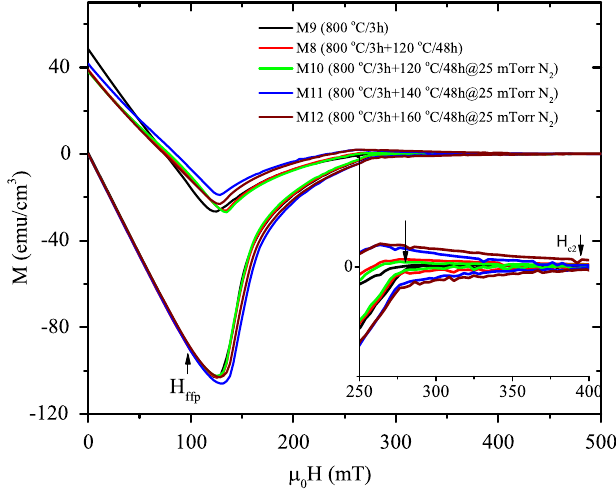
FIG. 9. Isothermal dc magnetic hysteresis of samples M8 – M12 measured at 4.2 K. The inset shows the M ð H Þ close to H c 2 showing an enhanced H c 2 for samples M11 and